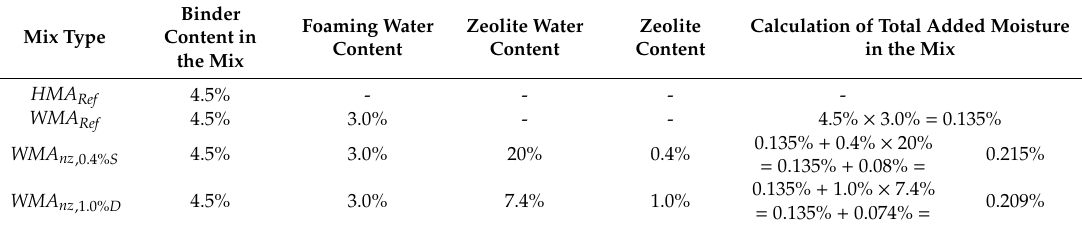
Table 2. The calculation of total added moisture in the investigated